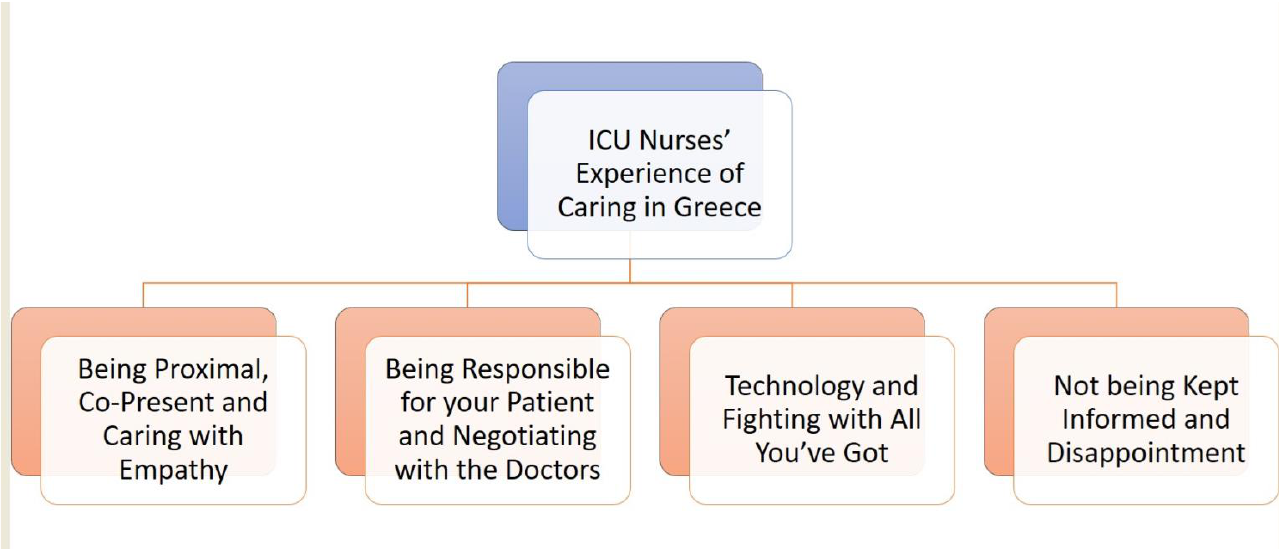
Figure 3. The main themes of the study.